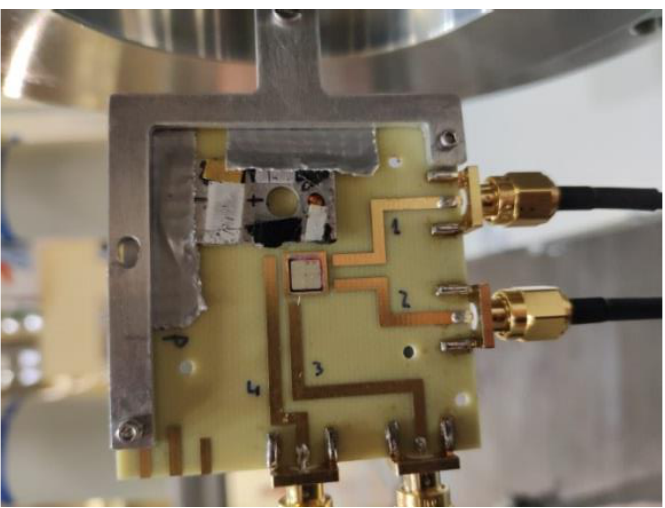
Figure 3. LGAD mounted in a dedicated PCB for IBIC, TRIBIC and TCT measurements installed in the sample holder of the CNA nuclear microprobe. On top of the detector there is an aluminum plate with scintillator materials, quartz and a copper grid for beam localization and focusing.